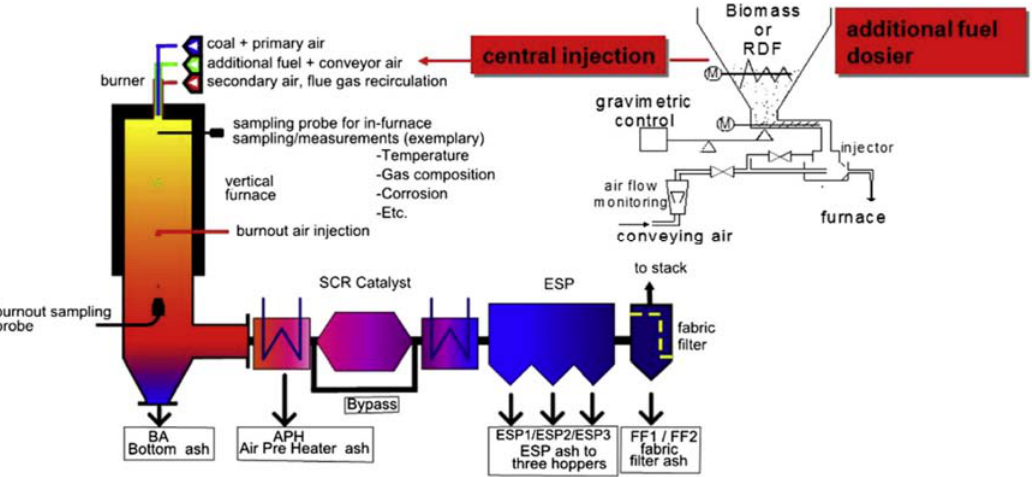
Figure 2. Institute of combustion and power plant technology (IFK) 0.5 MWth pulverized fuel pilot-scale test facility (KSVA).